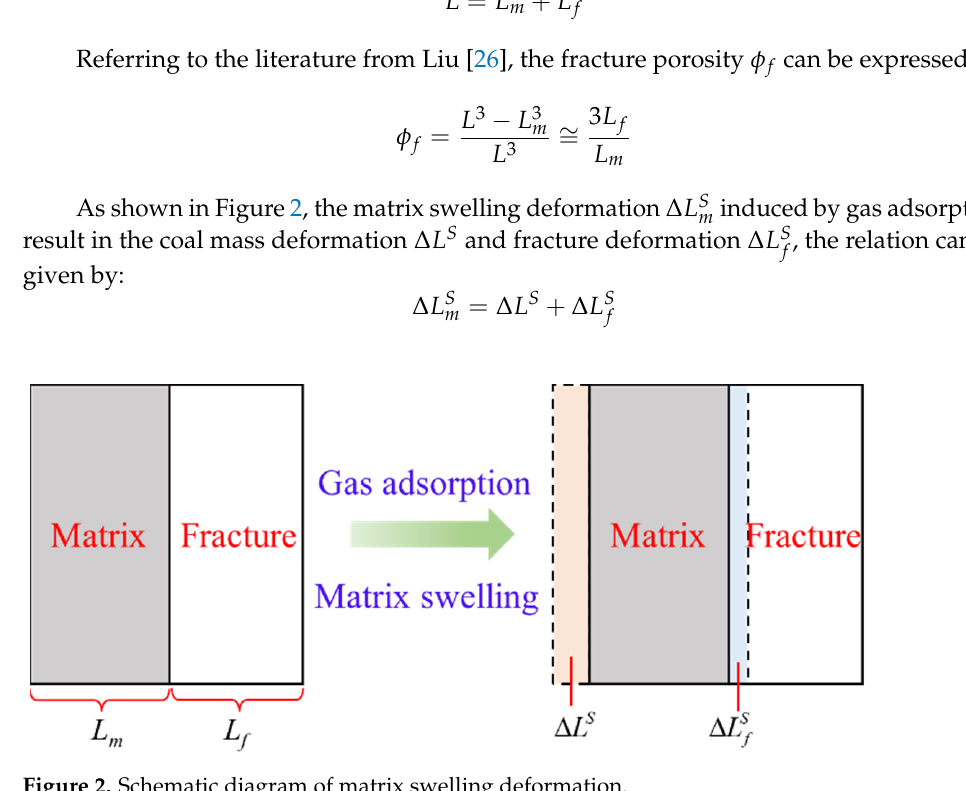
Figure 2. Schematic diagram of matrix swelling deformation. The mineral fillers between adjacent fracture surfaces limit matrix deformation into fracture to some extent, and the matrix will not expand evenly and equally on both sides